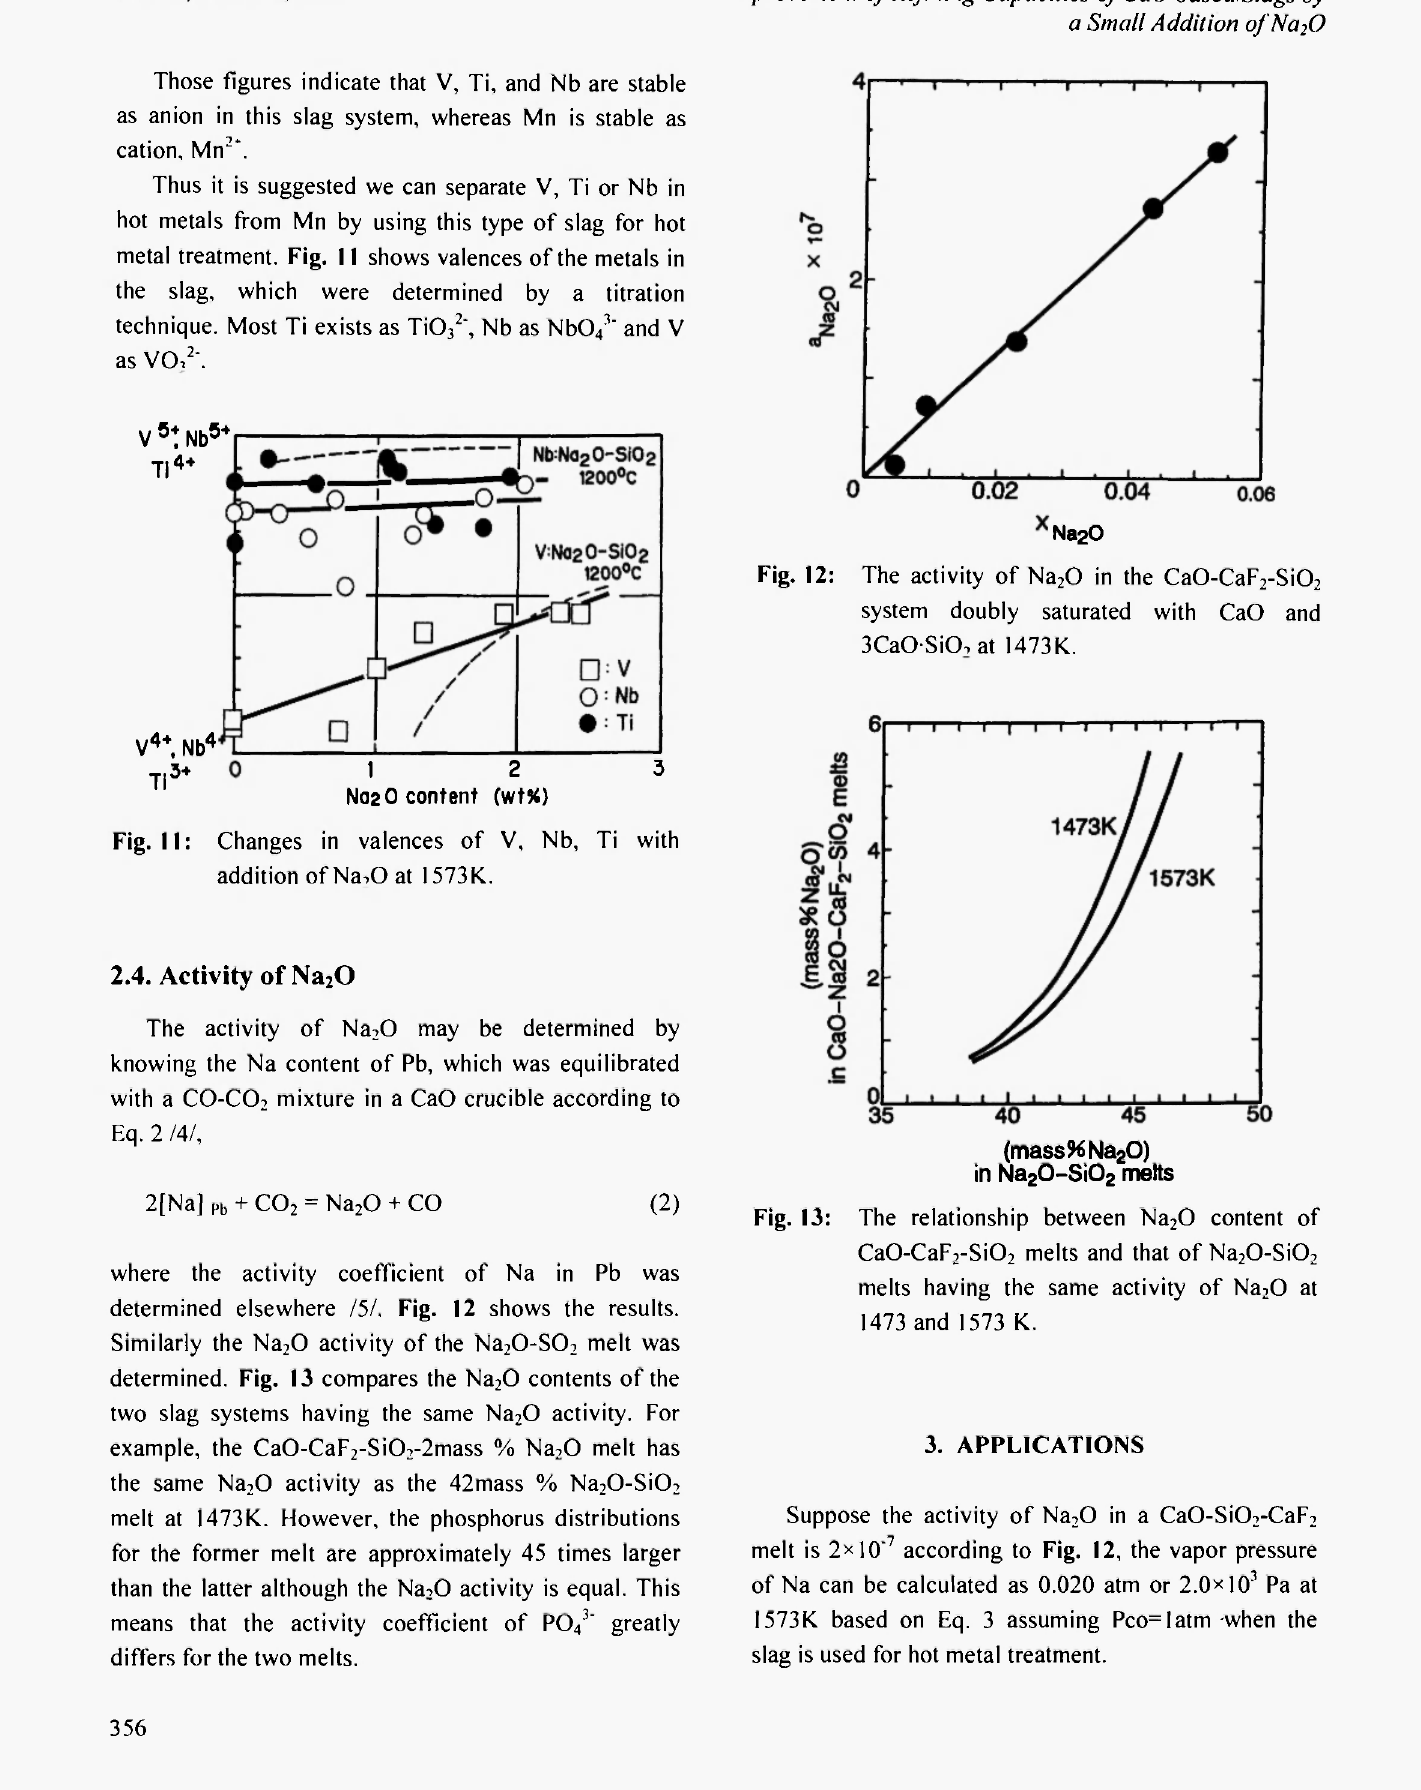
Fig. 12: The activity of N a 2 0 in the Ca0-CaF 2 -Si0 2 system doubly saturated with CaO and 3CaO-SiOi at 1473K.